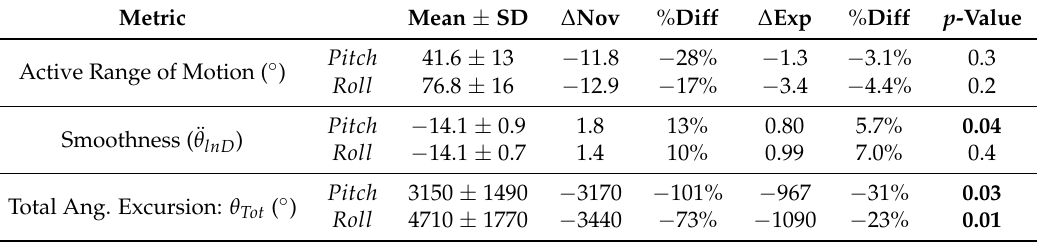
Table 2. Movement quality performance and learning differences for participants with video-game experience (n = 10). Descriptive statistics (mean ± SD) are presented across participants and trials. Motor learning was compared between the novice ( ∆ Nov, n = 5) and experienced ( ∆ Exp, n = 5) groups by evaluating each group’s change in metric between the first and last trials. The corresponding percent differences (%Diff) are also included. Significant differences ( p <0.05) are indicated with bold